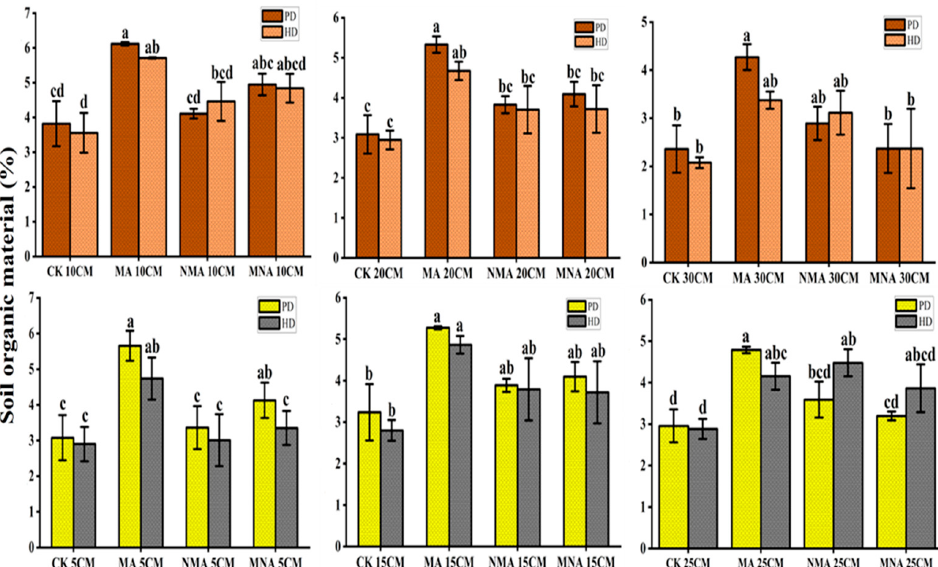
Figure 6. Effects of soil depth ( top row ) and distance from plant trunk ( bottom row ) on soil organic matter content. The bars are the standard error of the replications while the different letters on the bars indicate significant differences at p < 0.05.